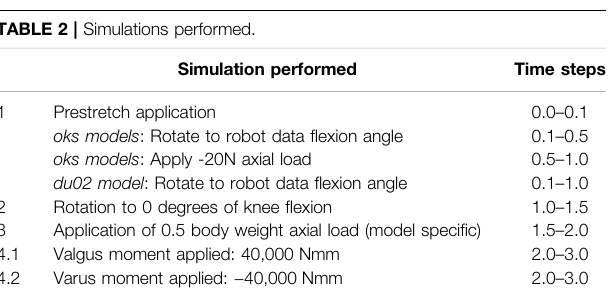
TABLE 2 | Simulations